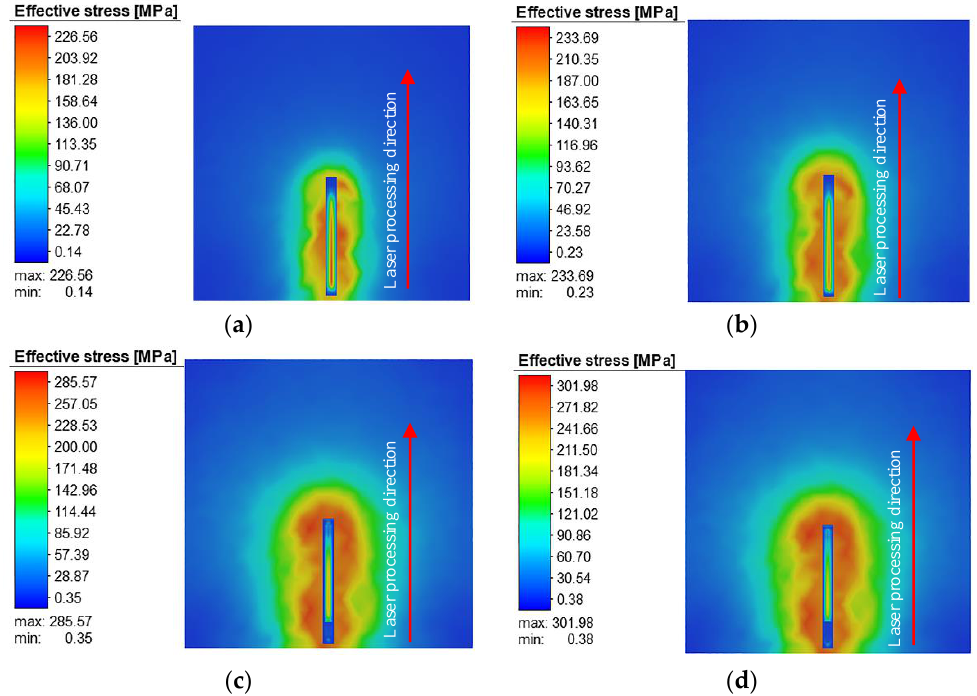
Figure 11. Stress variation for different layers at an energy density of 41.7 J/mm 3 : ( a ) layer 1, ( b ) layer 4, ( c ) layer 8, and ( d ) layer 10.